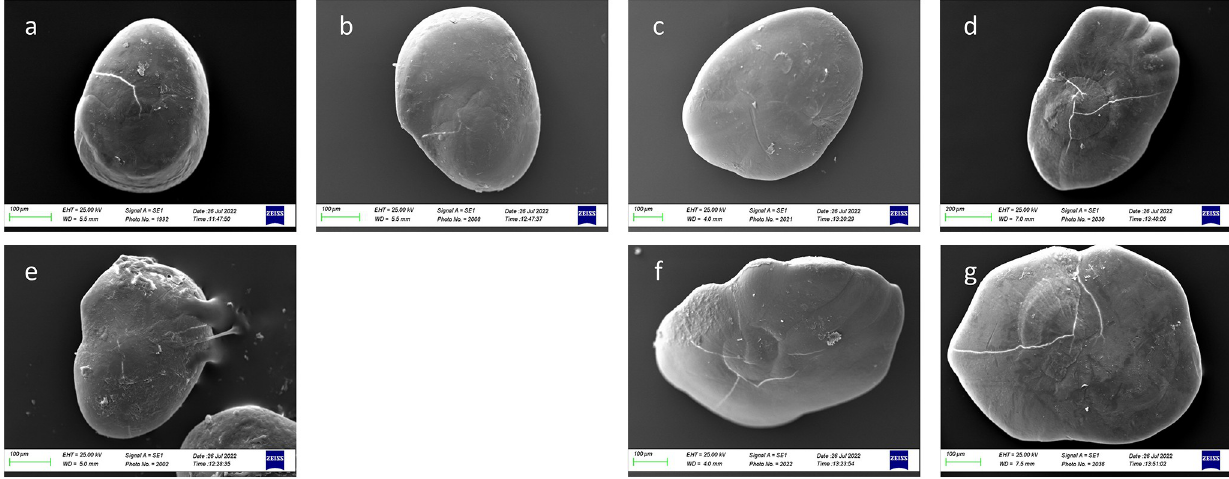
Fig 10. SEM images of A . hemigymnus’ sagittae inners (a, b, c, e) and external (d, f, g) surfaces separated for size classes: Class I (a, e), Class II (b), Class III (c, f) and Class IV (d, g).